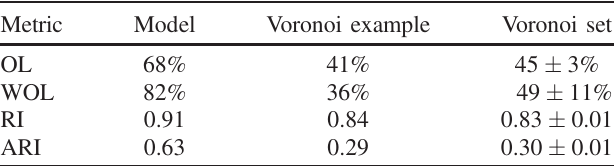
TABLE I. Metrics measuring the similarity between Trudgill ’ s predictions [4] for future English dialects and the predictions of our model. Metric acronyms are OL (overlap), WOL (weighted overlap), RI (Rand index), and ARI (adjusted Rand index). The Voronoi example column gives equivalent metrics for the example Voronoi tessellation in Fig. 8, and the Voronoi set column gives the mean metrics, with standard deviation, for five randomly generated Vornoi